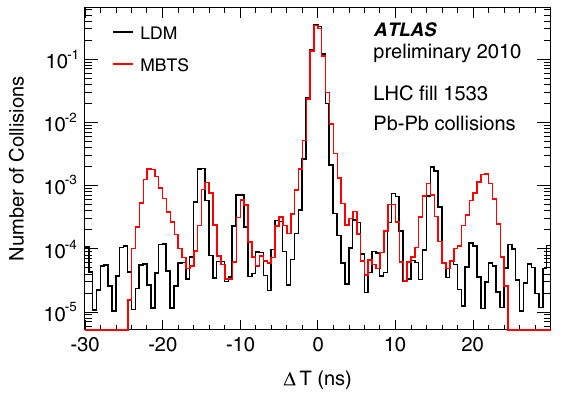
FIG. 7. Location of collisions in the ATLAS detector during the lead ion van der Meer scan in November 2010 (solid line), compared to the distribution derived from the LDM, assuming both beams had the same profile (dotted line). The peaks in the ATLAS data at (cid:4) 22 ns are due to beam losses outside the detector.